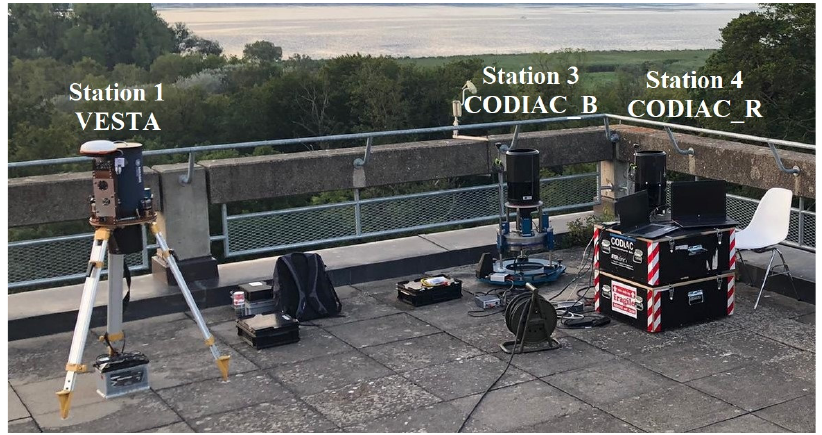
Figure 4. Comparative measurements of VESTA and two CODIACs at HEIG-VD. CODIAC_B: CODIAC Blue, CODIAC_R: CODIAC Red.